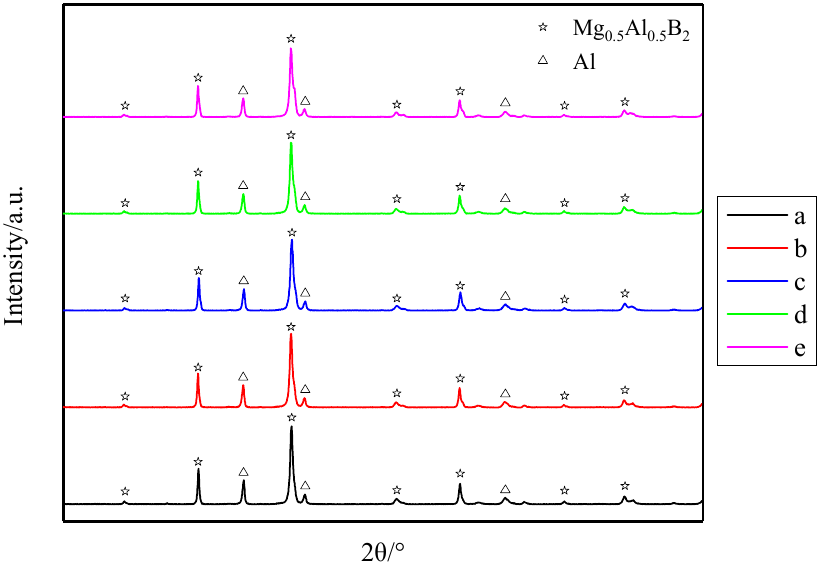
Figure 3. XRD patterns of samples sintered at 800 °C for different holding times: ( a ) 2 h, ( b ) 4 h, ( c ) 6 h, ( d ) 8 h and ( e ) 10 h.